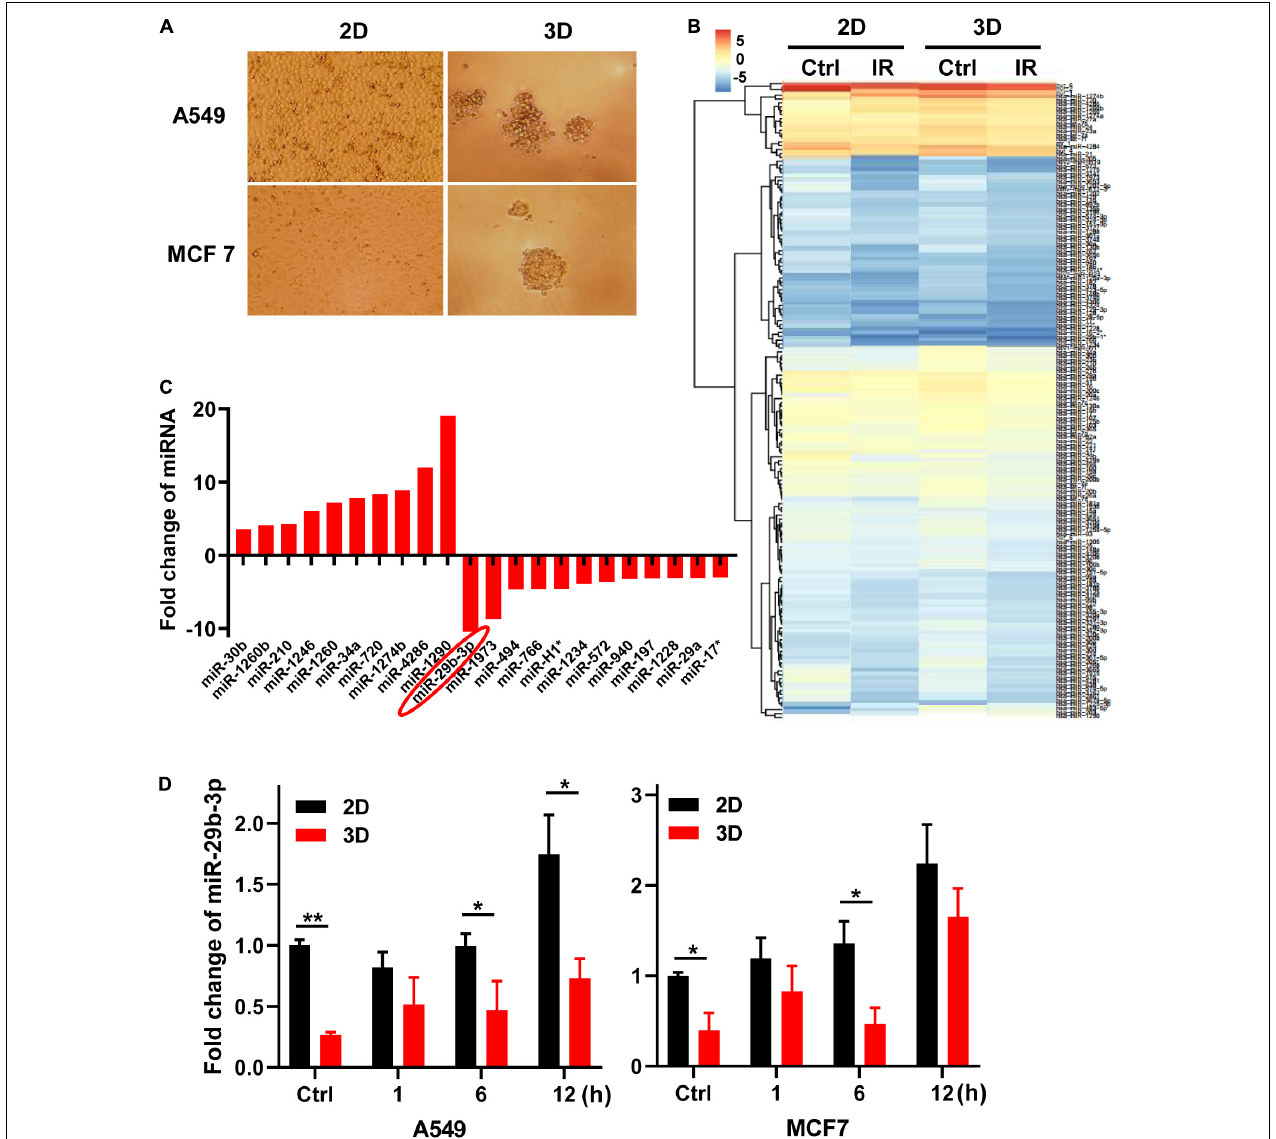
FIGURE 1 | MiR-29b-3p expression in 2D and 3D cultured A549 and MCF7 cells. (A) The morphology of 2D and 3D cultured A549 and MCF7 cells captured under a phase-contrast microscope. (B) Heat map of miRNAs microarray analysis in 2D and 3D cultured A549 cells 0.5 h after 5 Gy X-ray radiation. (C) Fold changes of miRNAs expression that are more than threefold between 2D and 3D cultured cells. (D) Relative miR-29b-3p expression measured by qRT-PCR at indicated time points in 2D and 3D cultured A549 and MCF7 cells after 5 Gy X-ray irradiation. U6 was used as an internal control. Ctrl, unirradiated groups. Significance was determined by unpaired t -test. * P < 0.05; ** P <